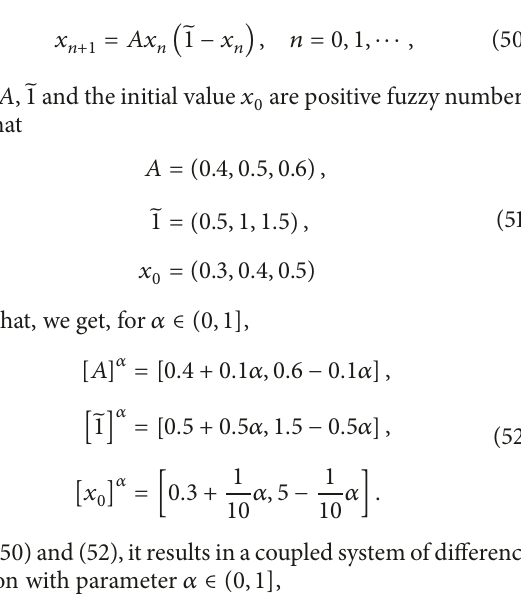
The solution of system (53) at  =0.25.